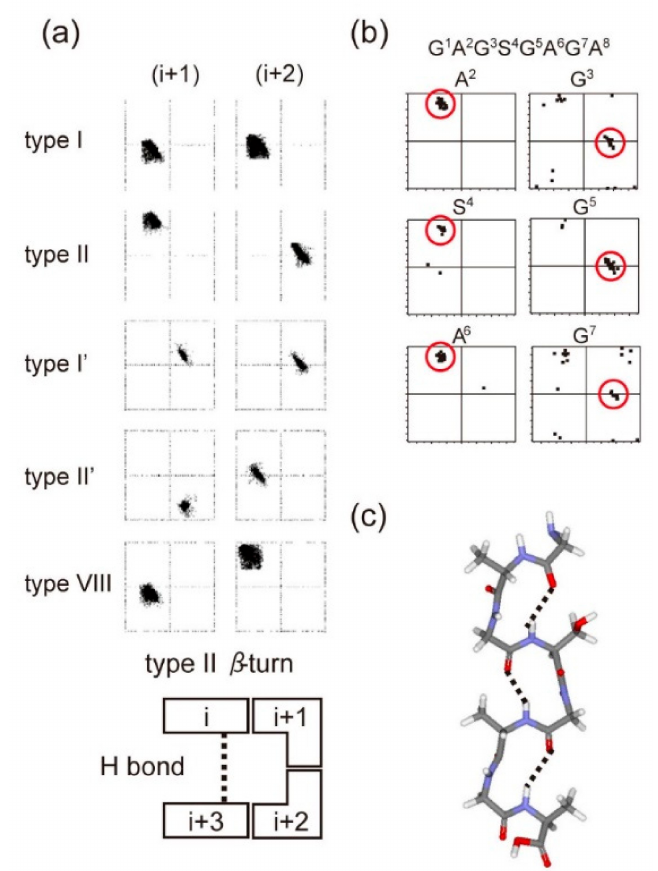
Figure 9. The relationship between the torsion angles ( φ , ψ ) of the (i + 1) and (i + 2)-th residues in Figure 8 and several types of β -turn structures. ( a ) The ( φ , ψ ) maps for typical type I, type II, type I (cid:48) , type II (cid:48) , and type VIII β -turns and an illustration of the type II β -turn conformation. ( b ) The 25 best matches for torsion angles ( φ , ψ ) of each residue of the GAGSGAGA motif obtained from the observed 13 C solution NMR chemical shifts of B. mori liquid silk using the TALOS-N program [77,78]. ( c ) The structural model constructed using the averaged ( φ , ψ ) angles in the red circles in ( b ) for each motif. Hydrogen bonds are assumed to exist between the CO of the (i)-th and the NH of the (i+3)-th residues for the GAGSGAGA motif [76]. Reprinted with permission from ref.